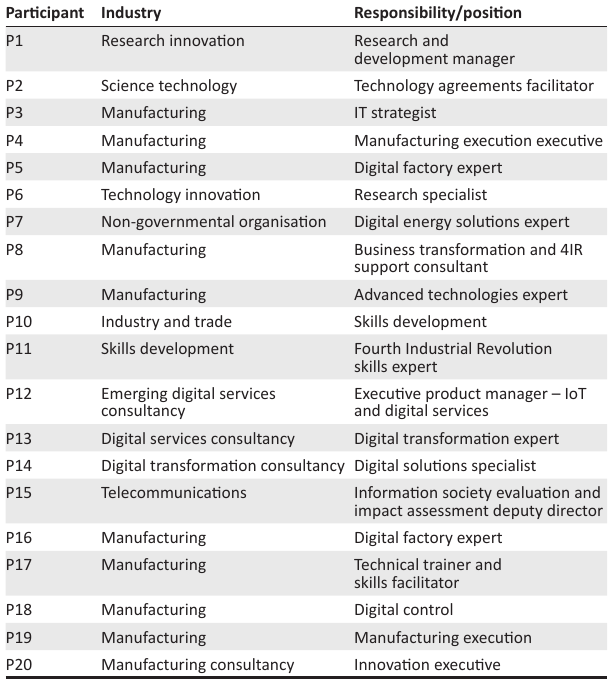
TABLE 1 : Participants’ industry and